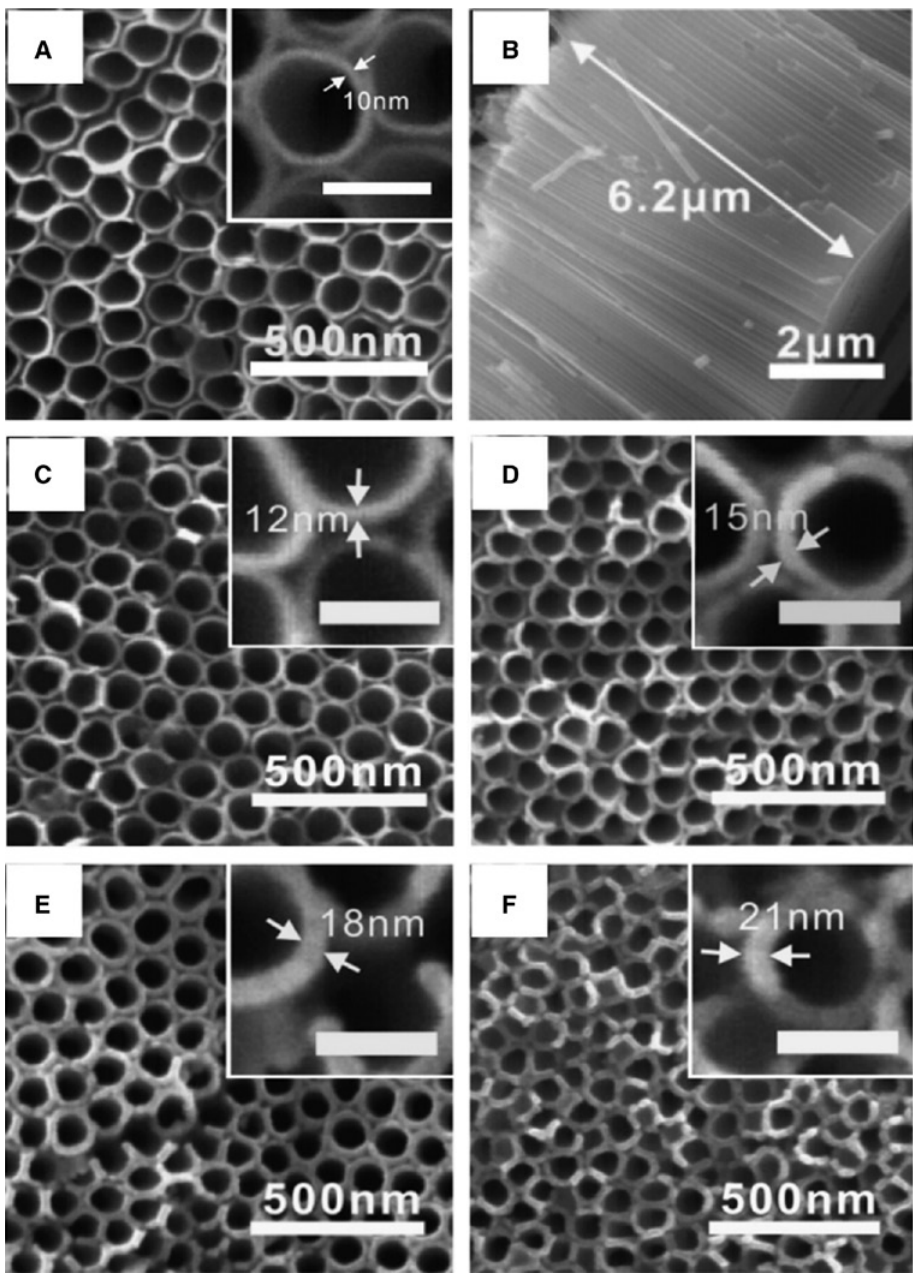
NTAs. SEM images of SrTiO /TiO prepared by hydrothermal reaction for 0.5 h (C), 2 3 2